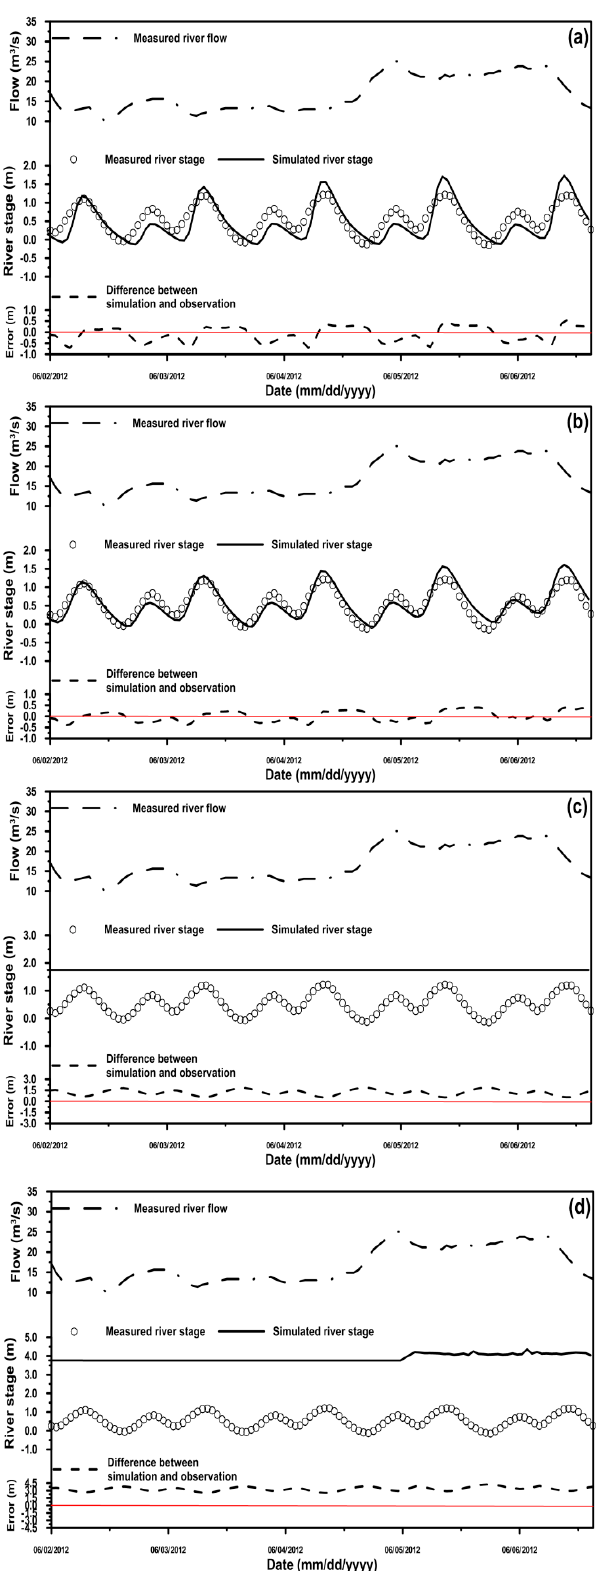
Figure 7. A comparison of the simulated and observed river stages at the Mashan Bridge under the low flow condition using the 2D model with the: ( a ) original cross-section data; and resampled cross-section data according to: ( b ) the linear interpolation method; ( c ) the IDW method; and ( d ) the NN method.